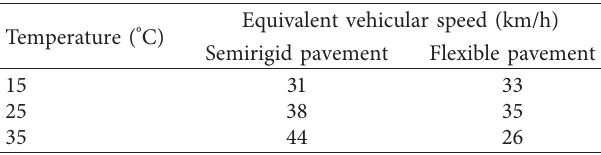
Table 8: The equivalent vehicular speeds of FWD loading for different pavements and temperatures.